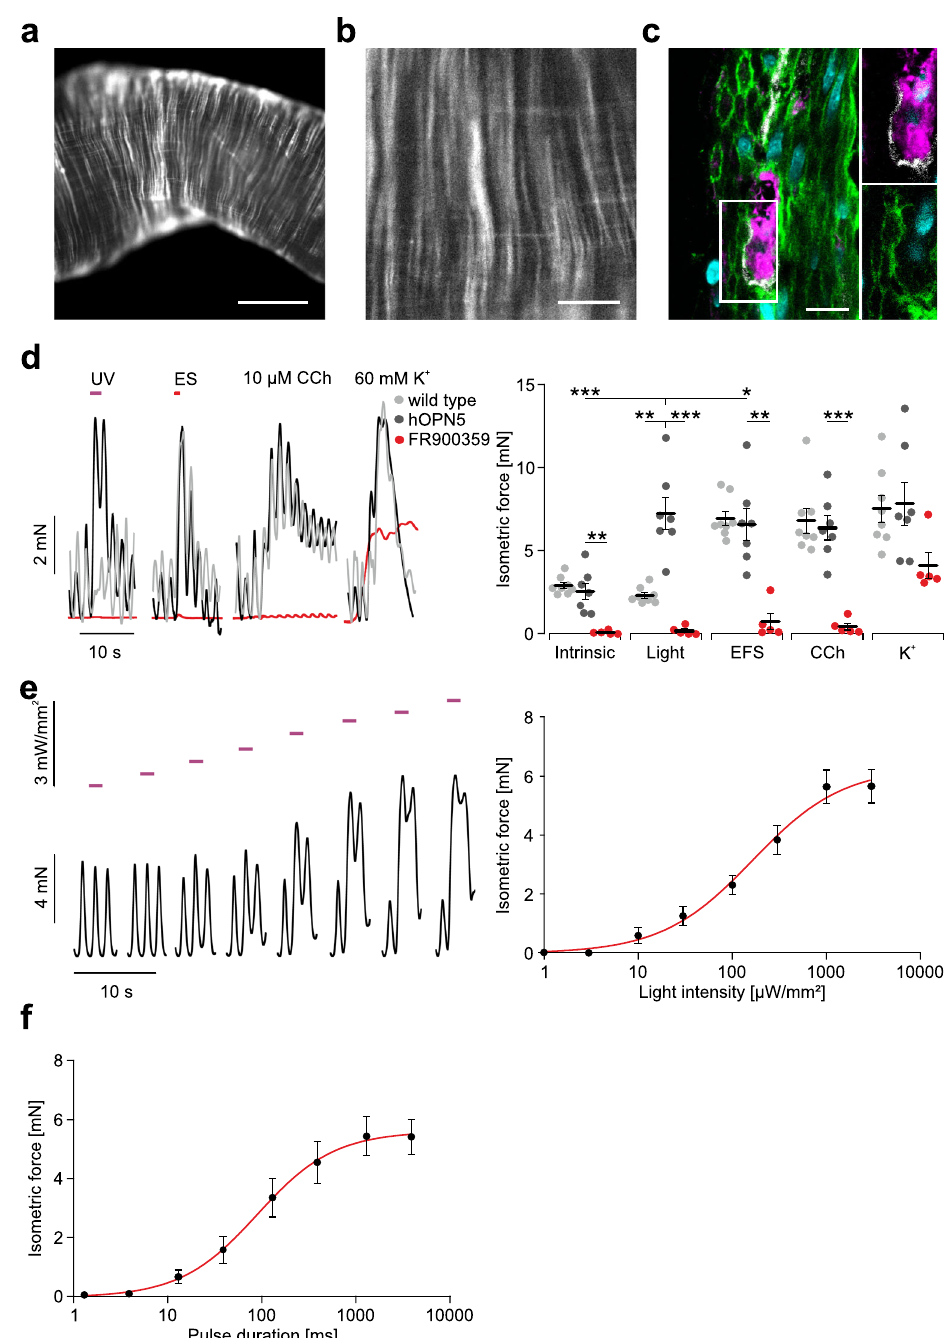
Fig. 8 UV light induced contractions in small intestine of hOPN5 mice. a , b eYFP- fl uorescence (white) in longitudinal as well as circular orientation in the small intestine of an hOPN5 mouse. c hOPN5/eYFP signals (green) in the tunica muscularis of the small intestine cannot be detected in c-kit positive Interstitial cells of Cajal (white) and β -III-Tubulin positive neurons (purple). Nuclear staining with DAPI (cyan). Bar = 2 mm in a , 400 µ m in b , and 10 µ m in c . d Representative traces (left) and aggregated data (right) of isometric force measurements of explanted small intestine from CD1 wild-type controls ( N = 3, n = 8; gray) and hOPN5 mice ( N = 3, n = 7) before (black) and after application of FR900359 (red, 1 µ M, N = 3, n = 5). Typical intrinsic contraction patterns can be observed and additional contractions were induced by UV light (violet bar, 2 s, 3 mW/mm 2 ), EFS (red bar, 1 s, 100 Hz, 2 ms pulses, 40 V), 10 µ M CCh and 60 mM K. + Statistical analysis was performed with two-way repeated measures ANOVA with Sidak ’ s multiple comparison test between CD1 WT vs. hOPN5, CD1 WT vs. hOPN5 FR and hOPN5 vs. hOPN5 FR (p(UV light): 0.0023, 0.0009, and 0.01, respectively; p(intrinsic): 0.62, 0.0009, and 0.04; p(EFS): 0.78, 0.005, and 0.03; p(CCh): 0.61, 0.01, and 0.007; p(K + ): 0.94, 0.15, and 0.29) and Tukey ’ s multiple comparison test for light effects in comparison to other stimuli in hOPN5 samples (p(vs. intrinsic): 0.0006; p(vs. EFS): 0.048; p(vs. CCh): 0.09; p(vs. K + ): 0.93). e Representative force traces (left) with 2 s long UV light pulses (violet bars) with increasing light intensity (from left: 1, 3, 10, 30, 100, 300, 1000, and 3000 µ W/mm 2 , light intensities displayed on a logarithmic scale) and aggregated data (right) of the light intensity to force relationship with a Hill fi t (red). f Analysis of pulse duration to force relationship for light pulses of constant intensity (3 mW/mm 2 ) with a Hill fi t (red). d , e : N = 2 mice; n = 5 stripes. Data are presented as mean values ±SEM. * p < 0.05, ** p < 0.01, *** p < 0.001.